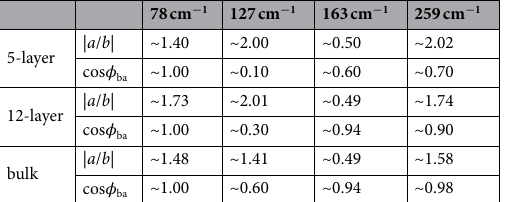
Table 1. The fitted values of | a / b | and phase difference 𝜙 ba for the detected A g ( A ′ ) modes in 5-layer, 12-layer and bulk 1 T´-MoTe 2